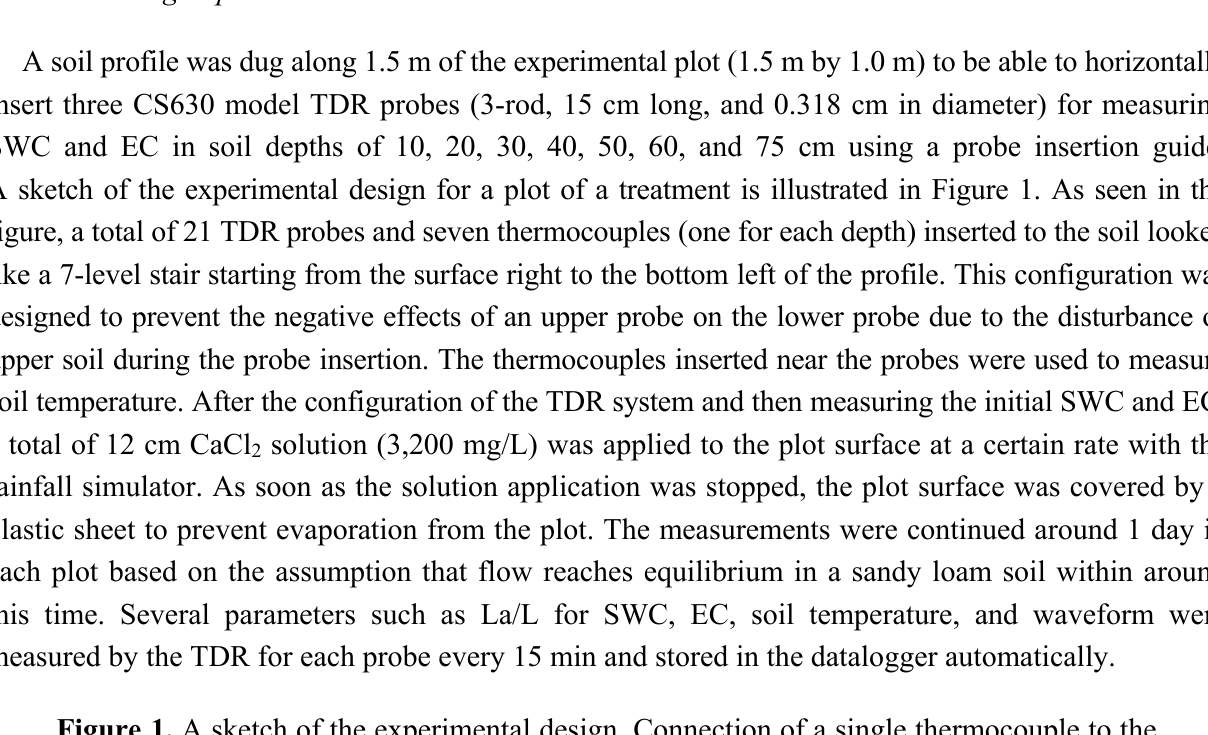
Figure 1. A sketch of the experimental design. Connection of a single thermocouple to the datalogger and connection of a single probe to the multiplexer are shown in the skecth to make presentation